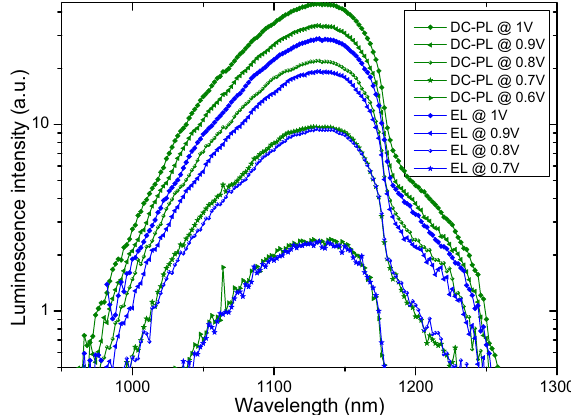
Fig. 2. Experimental EL and PL under DC-bias spectra.